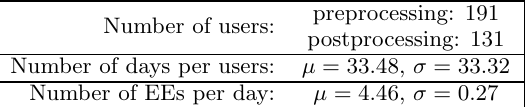
Table 5: Statistics of the dataset. Days per users and EEs per day are defined by their average ( µ ) and standard deviation ( σ )